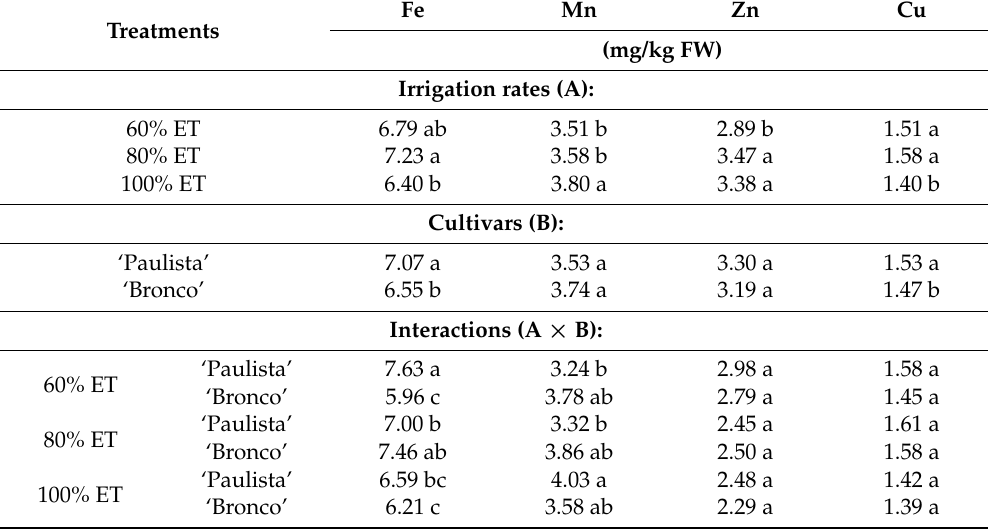
Table 5. Effect of different irrigation water volumes based on supplying 60, 80 or 100% of evapotranspiration (ET) on the content of microelements for two green bean